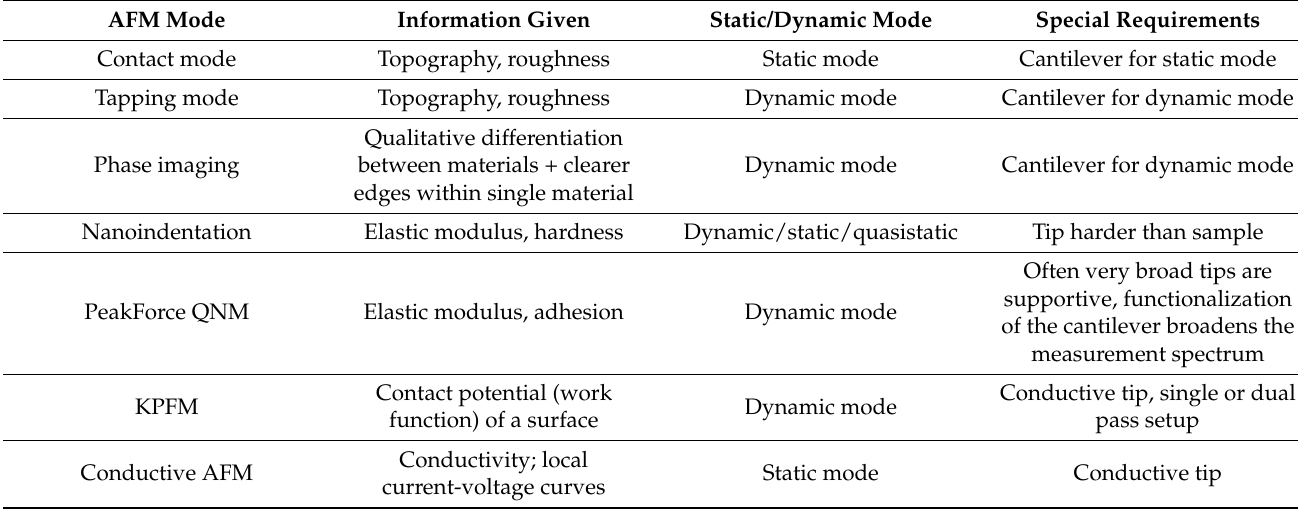
Table 1. Characteristics of different AFM